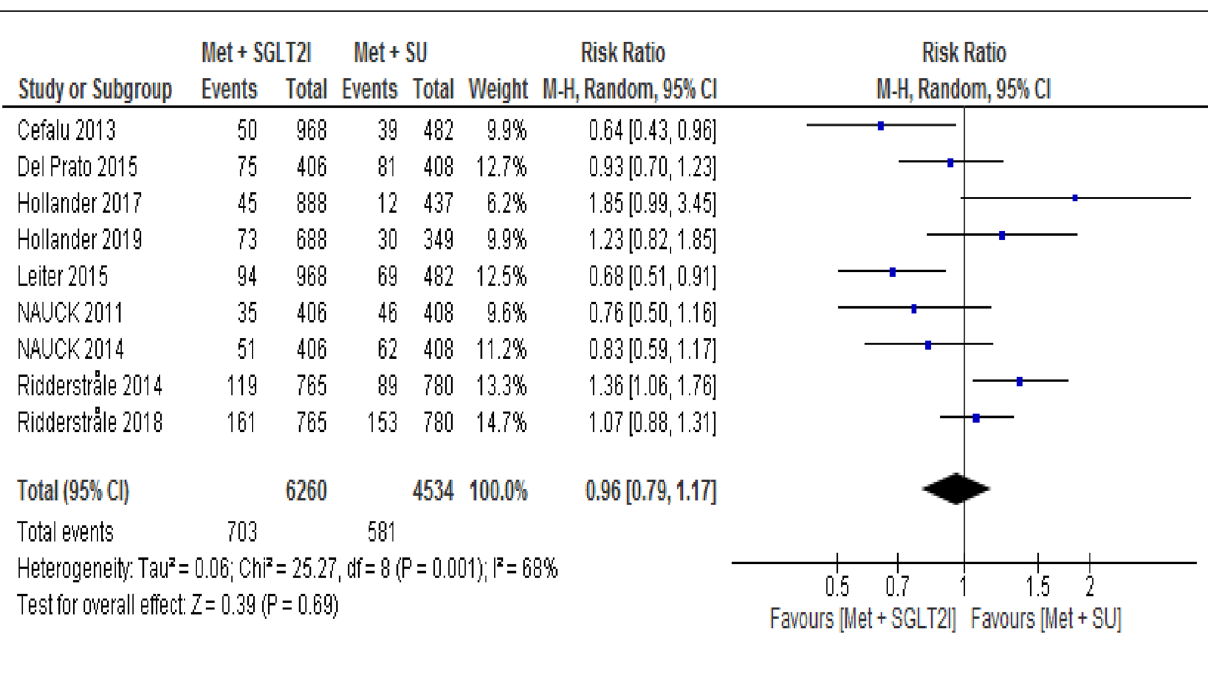
Figure 7. Risk of serious adverse events between patients who were on metformin-SGIT2I and metformin- sulphonylureas combination therapies. RR risk ratio; CI confidence interval; df degrees of freedom; Met metformin; SGLT2I sodium-glucose co-transporter 2 inhibitor; SU